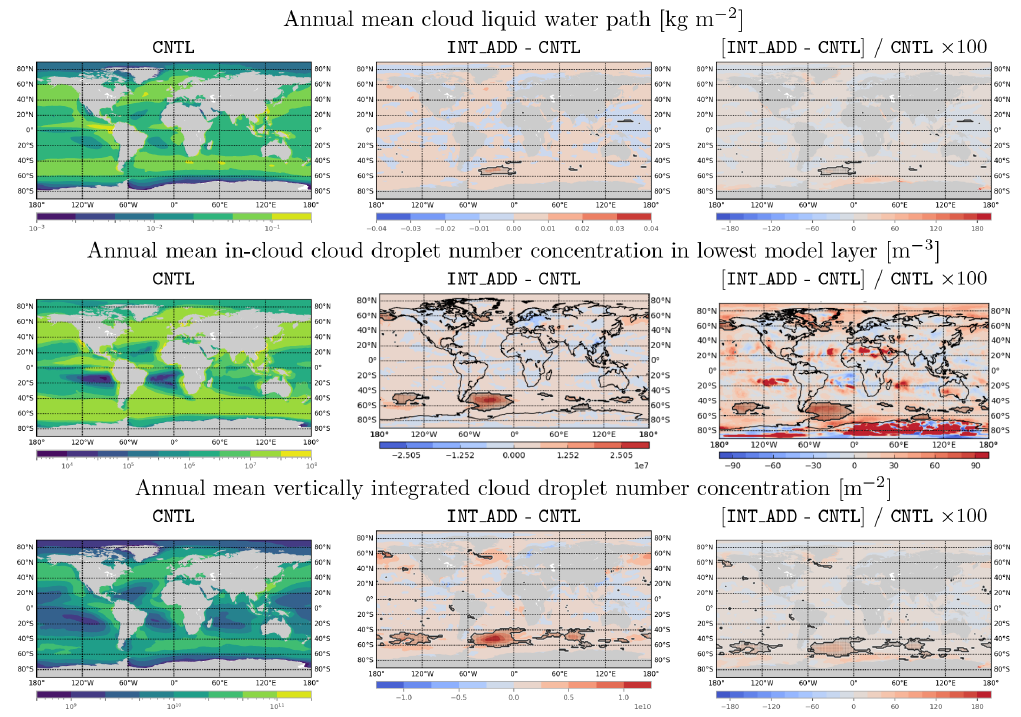
Figure 10. Annual mean modeled fields and changes in annual mean modeled fields due to introduction of MOA in the INT_ADD case. Shaded regions outlined with black contours indicate regions where absolute differences are statistically significant by Welch’s t test at the p < 0.1% level. White space indicates missing values. Top row: annual mean cloud liquid water path (kgm − 2 ) in CNTL (left) and absolute change (center) and percentage change (right) in INT_ADD . Second row: as above, for annual mean in-cloud droplet number concentration in the lowest model layer (m − 3 ). Third row: as above, for annual mean vertically integrated cloud droplet number concentration (m − 2